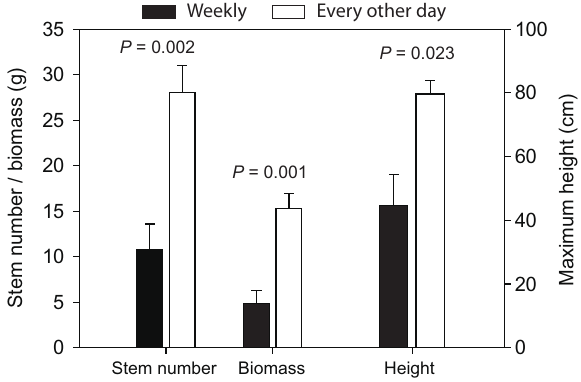
Figure 4. Cordgrass performance in different flooding treat- ments in the common garden experiment. (A) number of stems and maximum plant height and (B) biomass. Data are means + 1SE ( n =6). P -values from ANOVAs or Wilcoxon tests are